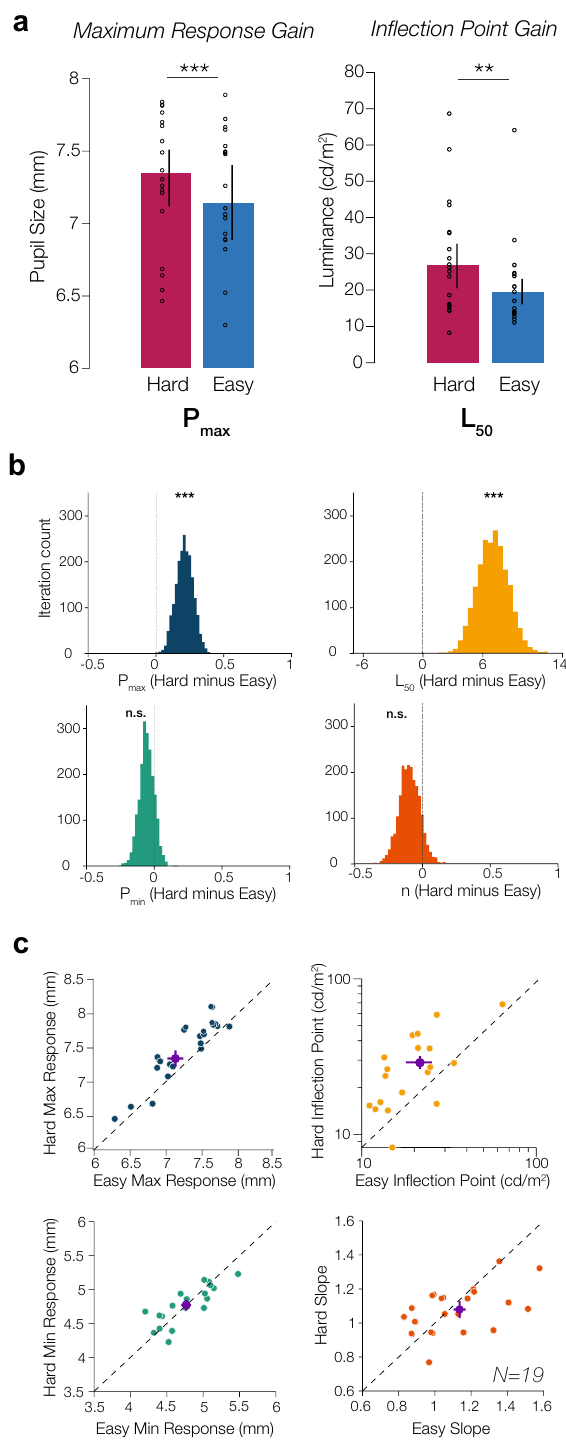
Figure 5. Parameter estimates. ( a ) Left: Mean parameter values for P max , maximum pupil response at lowest luminance for the Hard (red) and Easy (blue) condition. This parameter reflects a multiplicative gain of pupil size response, such that maximum pupil response is higher in the Hard condition than in the Easy condition. Right: Mean parameter estimates for L 50 , the inflection point or luminance value at half maximum pupil response, for both the Hard and Easy condition. Each circle represents the parameter estimate of an individual observer, and the error bar represents the 95% confidence interval. ( b ) Bootstrapped distributions (2000 iterations) of the difference between Hard and Easy parameter estimates for P max , L 50 , P min , and n. ( c ) Scatterplot of individual observer parameter estimates comparing Hard versus Easy for P max , maximum pupil response, L 50 , inflection point, P min , minimum pupil response, and n, slope. The purple dot indicates the group-averaged parameter estimates, with the error bars indicating the SEM. The dotted line indicates the unity line of no difference in parameter estimates between the Easy and Hard